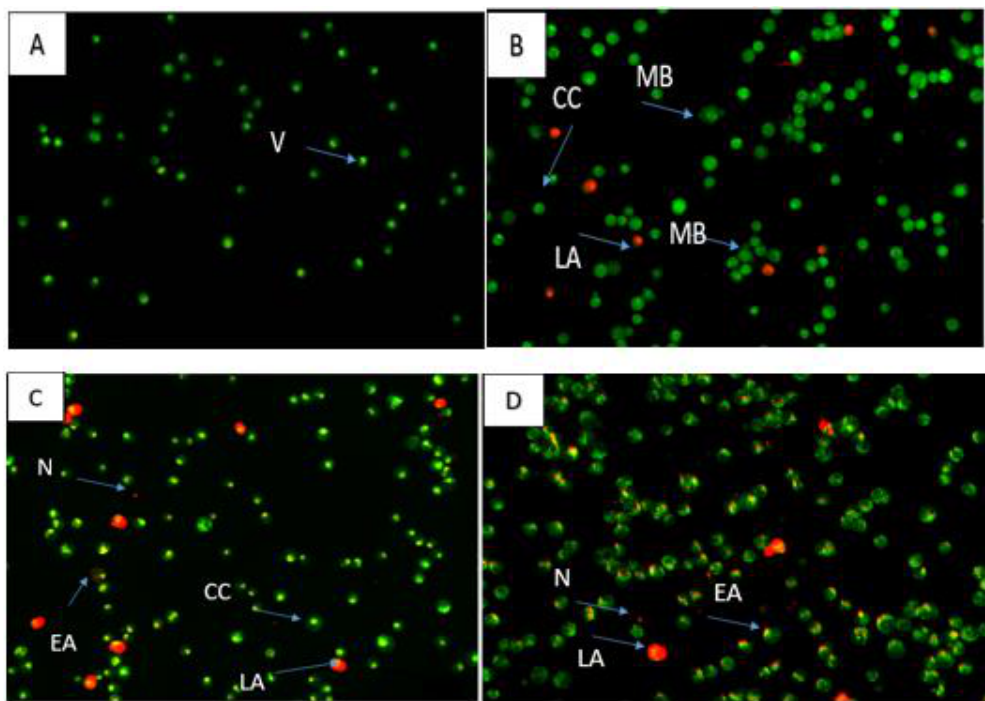
Figure 13. Fluorescent microscopic images of MCF-7 cells stained via AO/PI double staining. Control cell ( A ), cells treated for 24 h ( B ), 48 h ( C ), and 72 h ( D ). Viable cells (V), early apoptosis (EA), chromatin condensation (CC), membrane blebbing (MB), late apoptosis (LA), necrosis (N) .